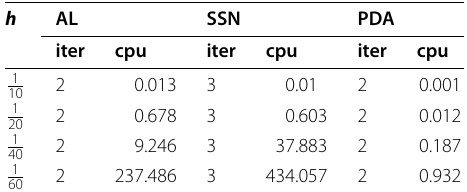
Table 2 Comparisons of iteration numbers and execution times for Problem 1